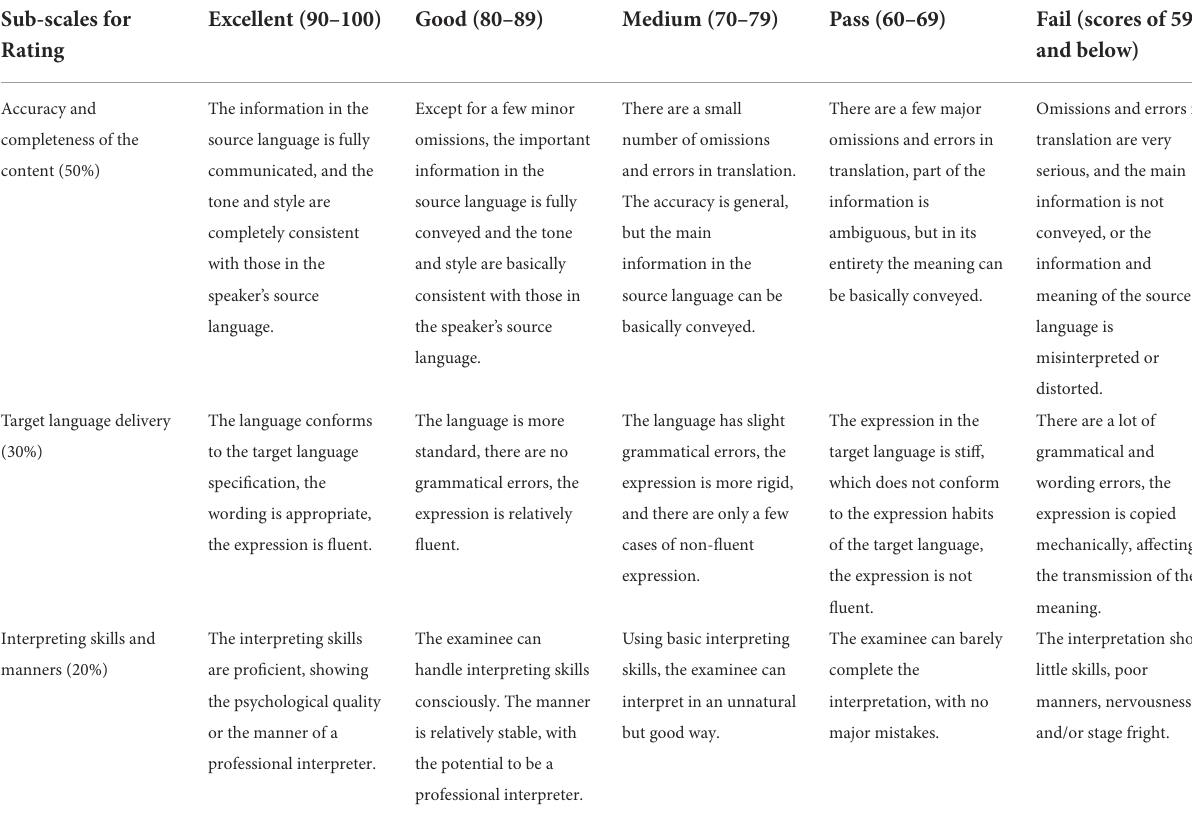
TABLE 3 Analytic rating scale for interpreting test (Adapted from the rating scale of the TAC national interpreting